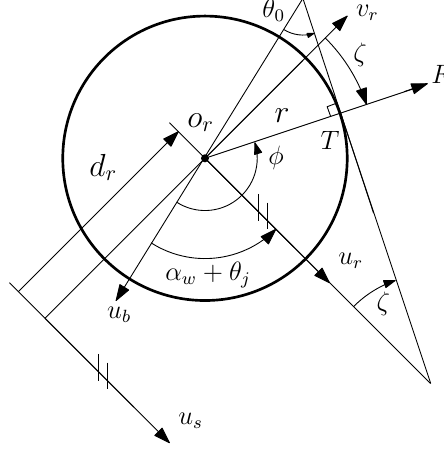
Figure 3. Rolling contact geometry